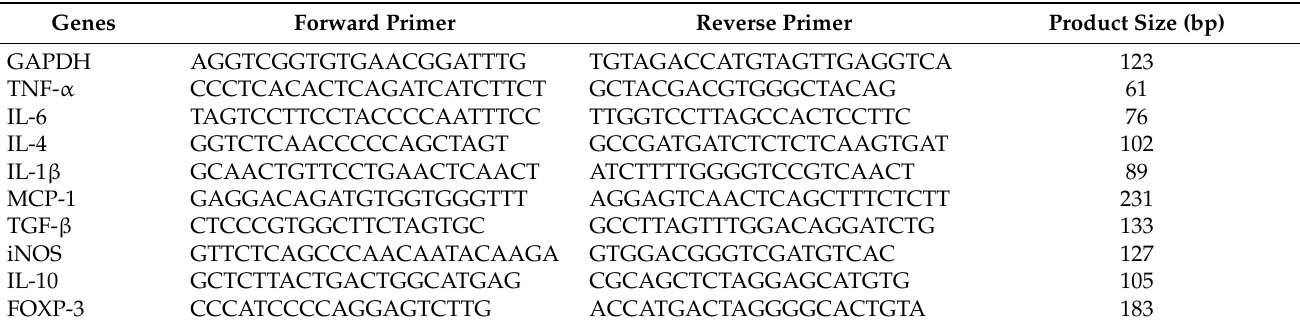
Table 2. Primer sequences for quantitative real-time